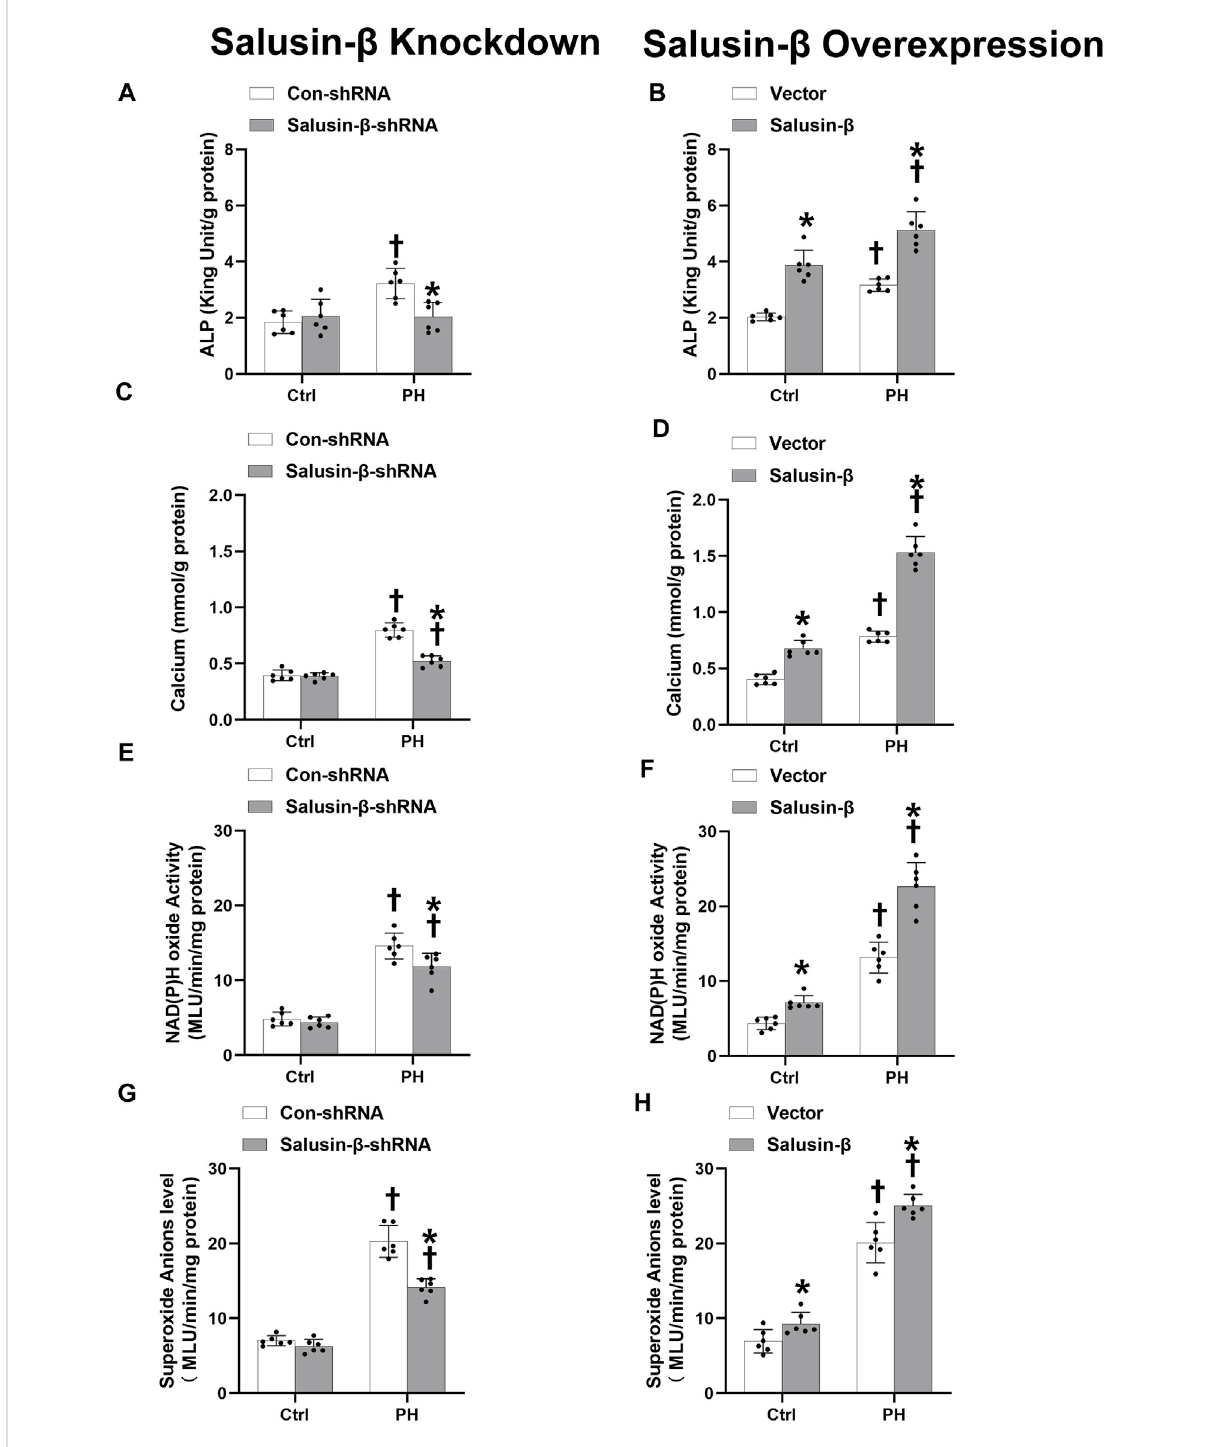
FIGURE 8 Effect of salusin- β knockdown on ALP activity (A) , calcium content (C) , NAD(P)H oxidase activity (E) and superoxide anions level (G) ; as well as the effects of overexpression of salusin- β on ALP activity (B) , calcium content (D) , NAD(P)H oxidase activity (F) and superoxide anions level (H) of PASMCsisolatedfromcontrolandMCT-inducedPHrats.Valuesaremean±SE.* p < 0.05comparedwithCon-shRNAorvector. † p < 0.05compared with control (Ctrl) rats. n = 6 for each